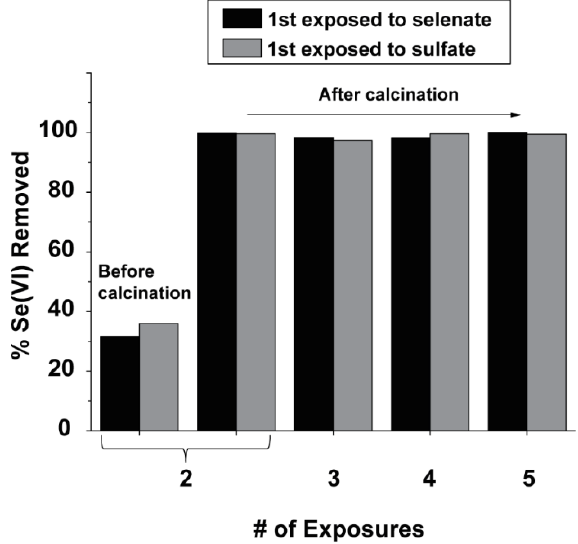
Figure 11. Removal of selenate using LDH-500C that was exposed to 50 ppm selenate or sulfate solution and then regenerated. For each regeneration cycle, the used LDH-500C was calcined at 550 ◦ C for 2 h.